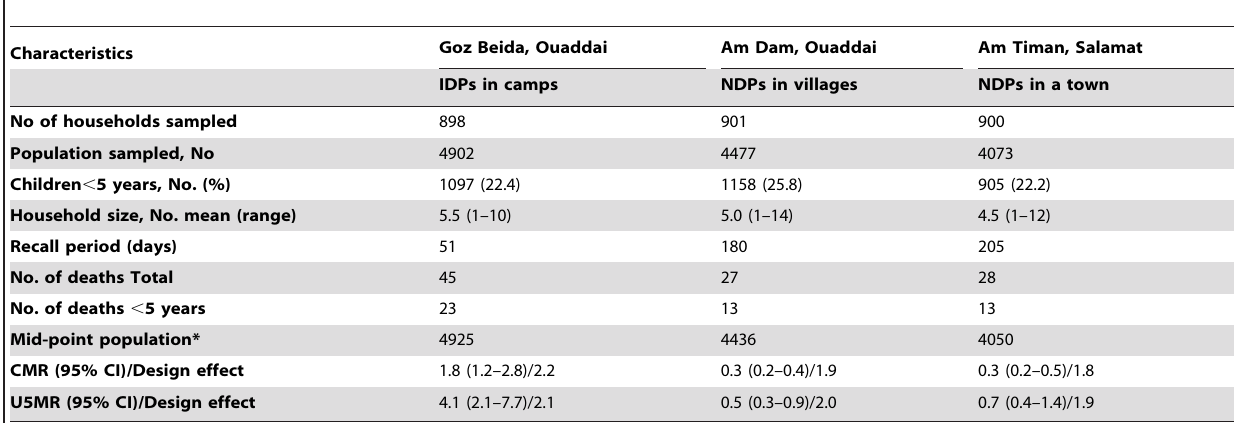
Table 1. Survey profiles and mortality rates by age group and location in Ouaddai and Salamat regions.